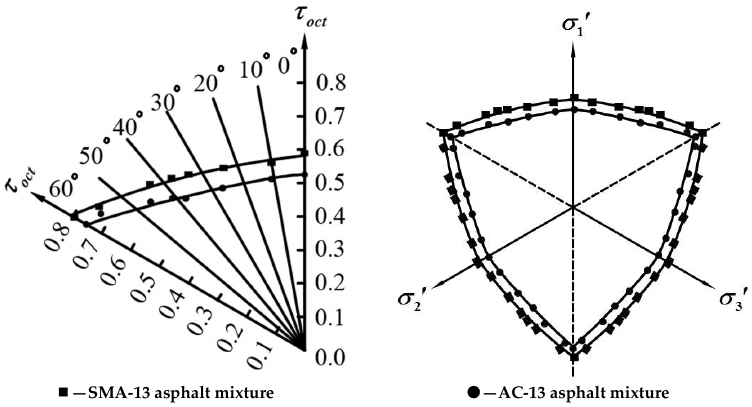
Figure 8. Nonlinear tensile and compressive meridians.